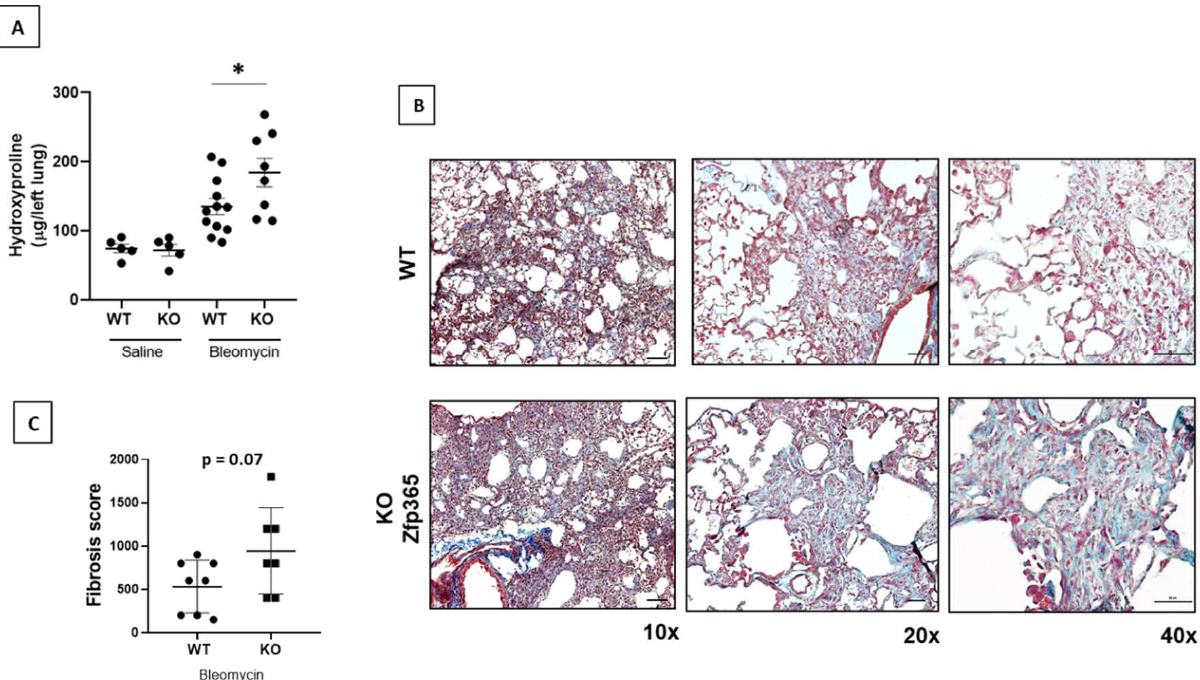
Figure 4. An exacerbated fibrotic response was observed in Zfp365-deficient mice. ( A ) Lung hydrox- yproline content at 21 days after bleomycin instillation of Zfp365 KO mice ( n = 8) and WT ( n = 12). ( B ) Representative light microscopy images of Masson’s trichrome stained lung tissue sections in three different magnifications (scale bars 100 and 50 μm) from WT and Zfp365 KO mice 21 days after bleomycin instillation. ( C ) Fibrosis score for grading lung histopathological changes. Results are shown as mean ± SEM. Statistical significance was determined by the Student’s t -test with Welch’s correction (* p < 0.05).